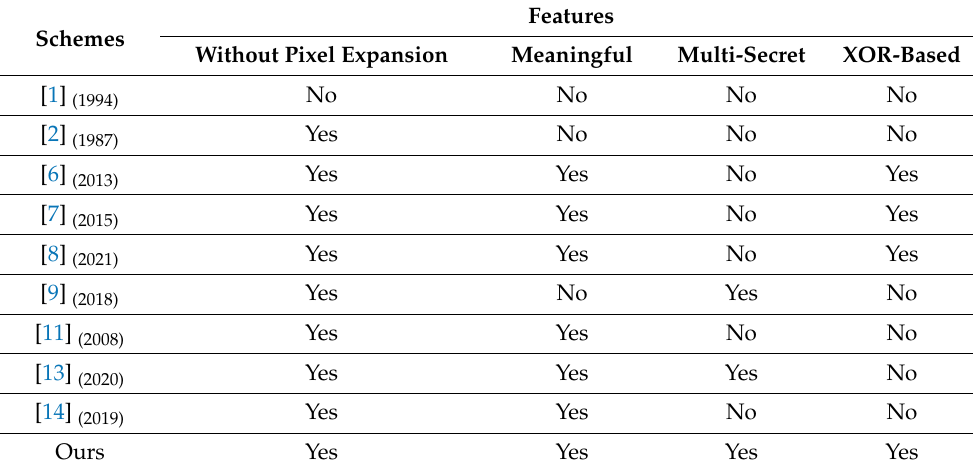
Table 6. Compare the proposed scheme with related works. Features Schemes Without Pixel Expansion Meaningful